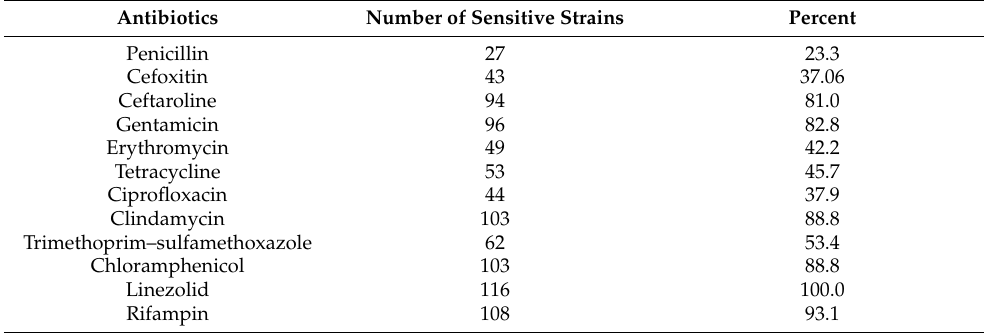
Table 2. Susceptibility pattern of S. aureus (n =